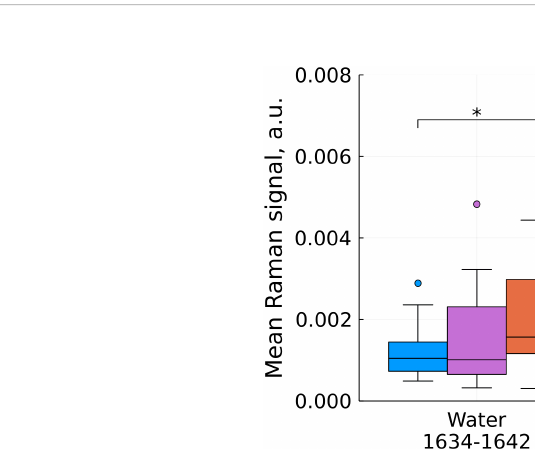
FIGURE 6 Mean Raman signal in bands of water and hemoglobin (blue – normal tissue, magenta - tumor edge, orange - tumor center). Numbers in horizontal labels denote the range of Raman shifts.